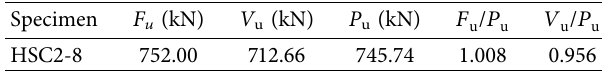
Figure 22: Experimental values and calculated values of shear strength. Table 3: Comparison between the calculated values from equations of flexural strength ( F u ) and shear strength ( V u